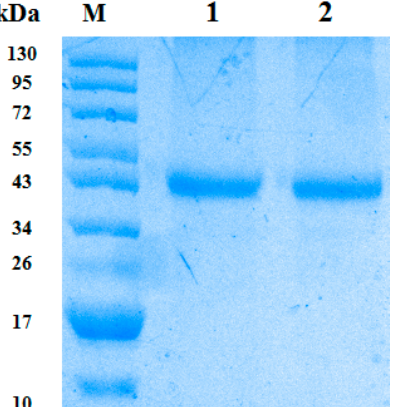
Figure 3. The expression and purification of GST-CypA. The CypA protein of yellow catfish was GST-fused expressed, purified and confirmed through SDS-PAGE, where the M represents the protein marker, Lane 1 represents CypA wt and Lane 2 represents CypA mt in this figure.